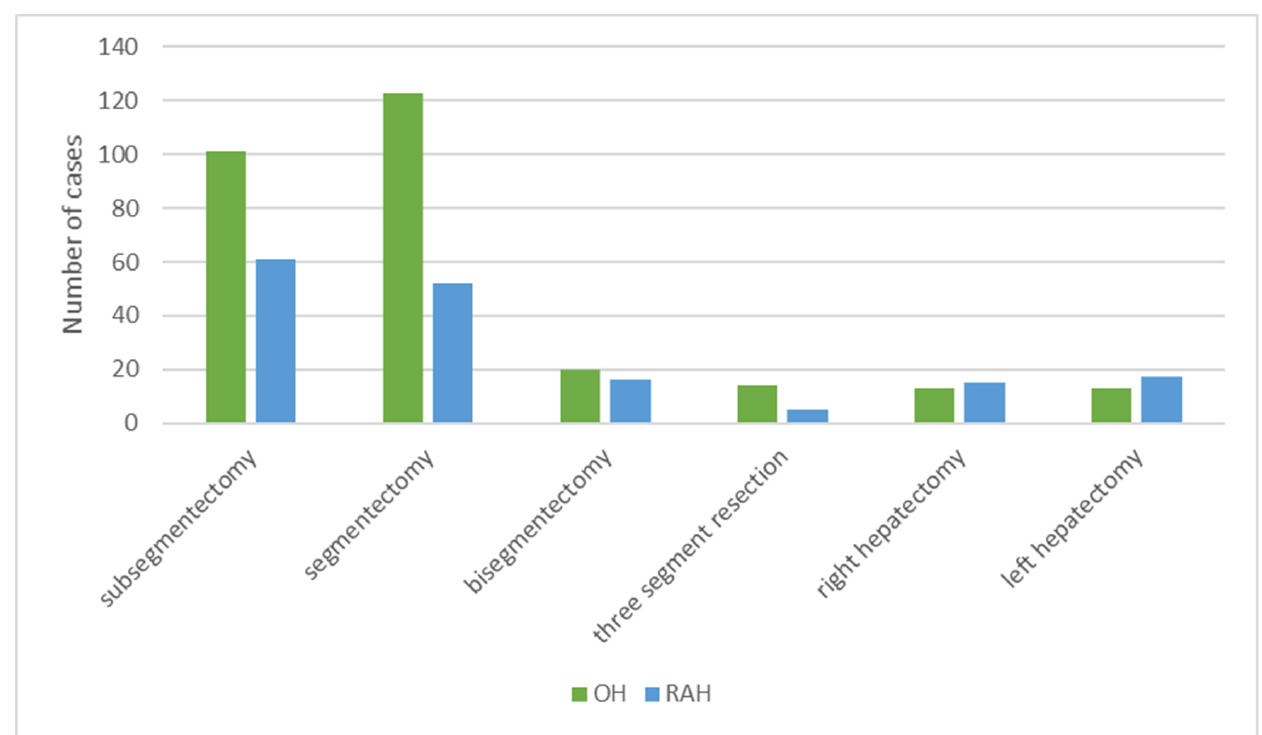
Figure 8. Distribution of surgeries in OH and RAH. Table 4. Aggregated demographics for RAH versus OH comparison.